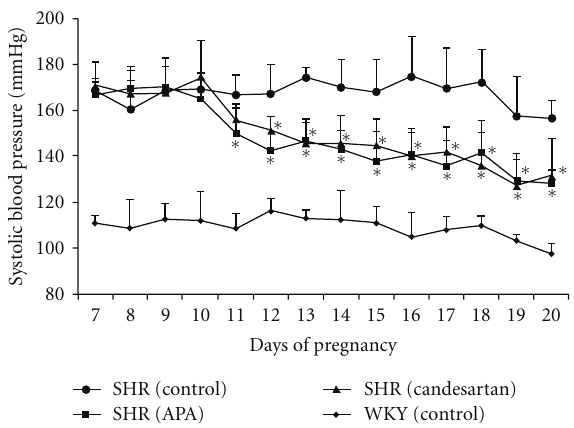
Figure 5: Changes of SBP during mid- and late-term pregnancy in SHRs with and without administration of APA and candesartan and WKYs without administration of any drugs . SHR (control, n = 5), SHR (APA: 0.016–0.16 mg/kg/day, n = 5), SHR (candesartan: 0.1– 1mg/kg/day, n = 5), and WKYs (control, n =